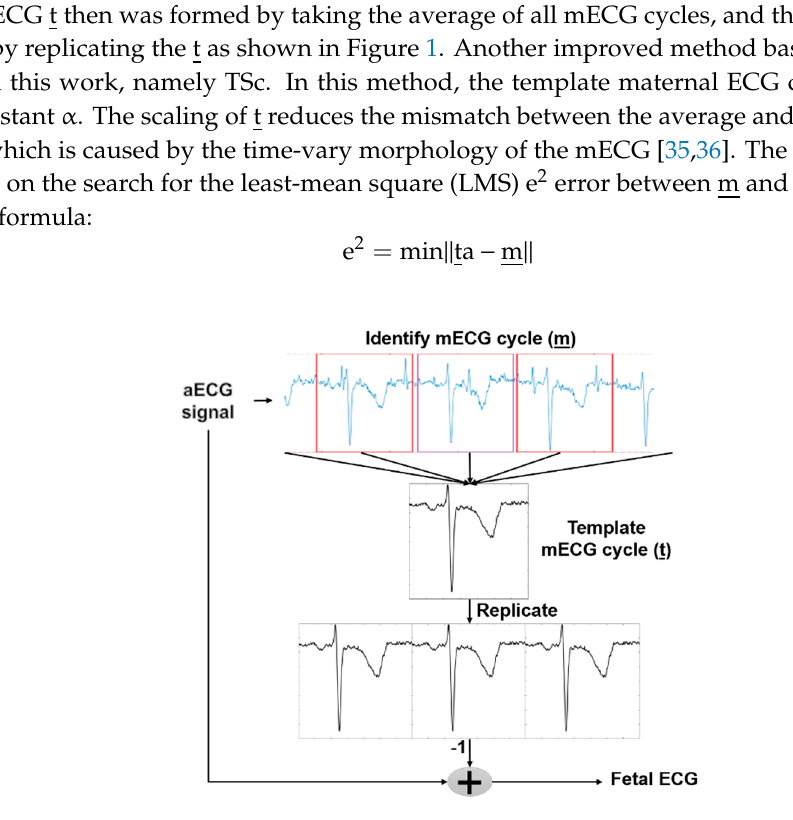
Figure 1. Template subtraction (TS)’s illustration for abdominal electrocardiogram (aECG).